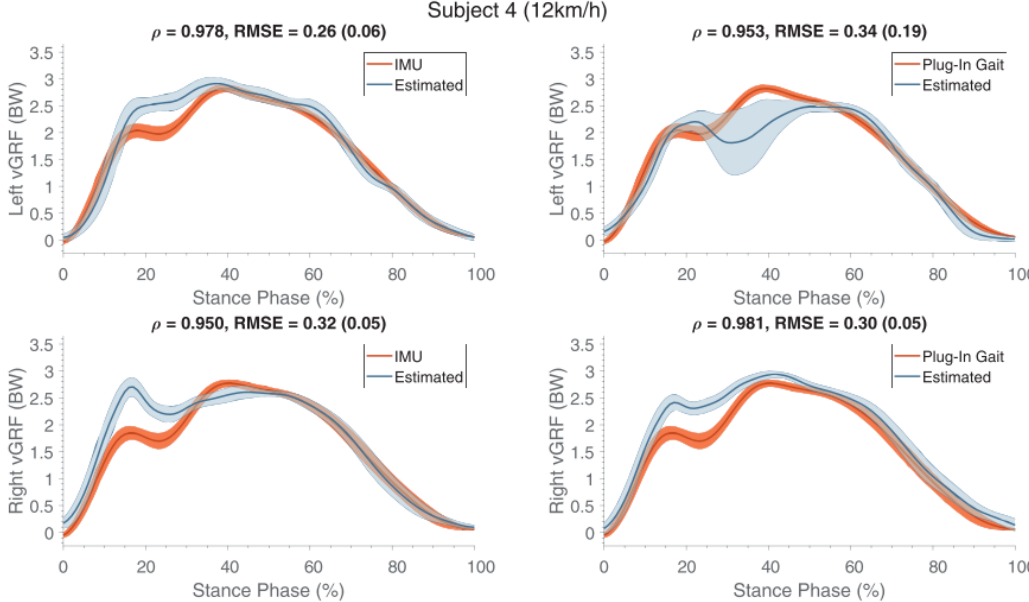
Figure 23. The estimated GRF profiles are compared to the respective reference profiles. Reference profiles were classified according to the respective reference kinematics (IMU and Plug In Gait joint angle output) [89]. These estimates were obtained using training datasets from different subjects. Left forces are depicted on the first row, while right stances are on the bottom row. At the top of each graph it is reported the comparison between the curves in terms of: the Pearson correlation coefficient, the RMSE and its standard deviation [89].